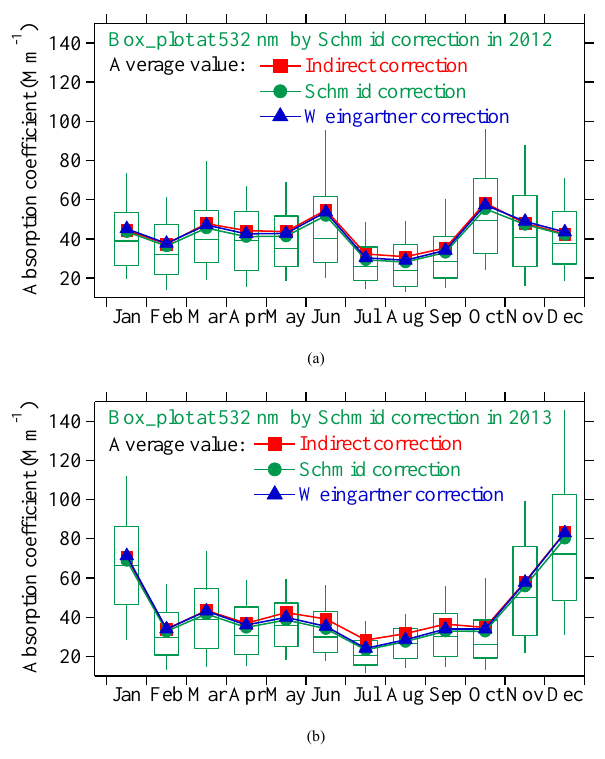
Figure 3. Monthly variations of the aerosol absorption coefficients (Mm − 1 ) at 532nm in the urban area of Nanjing in 2012 (a) and 2013 (b) . The 10th, 25th, median, 75th, and 90th percentile val- ues of the coefficient corrected by SC2006 are presented as box plots. The monthly means of the coefficients corrected by IDC (red), WC2003 (blue), and SC2006 (light green), are presented as line